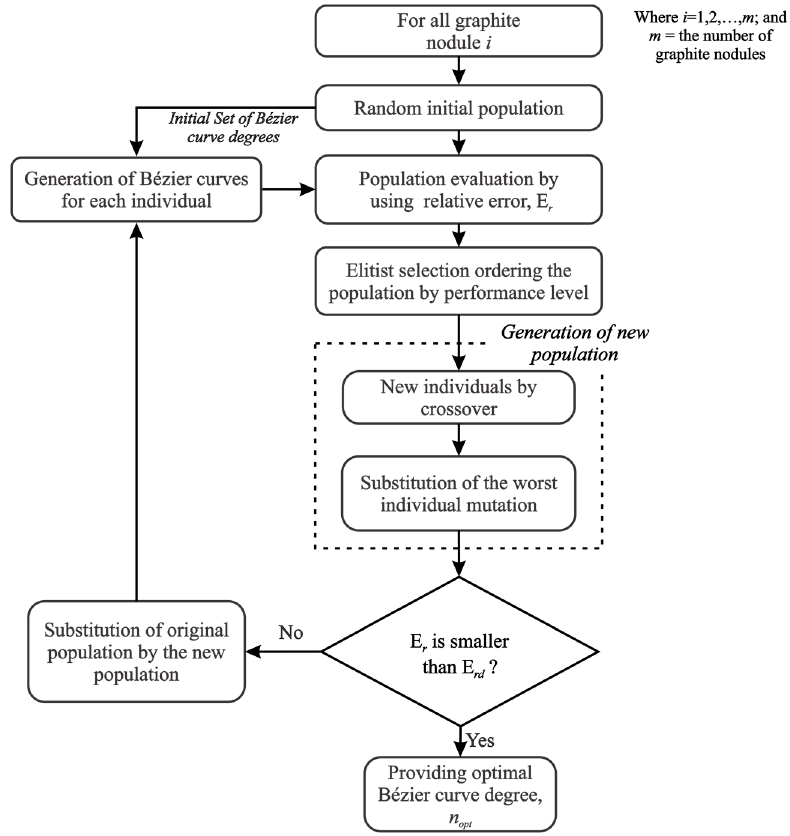
Figure 5. General scheme of the Bézier curves optimization.